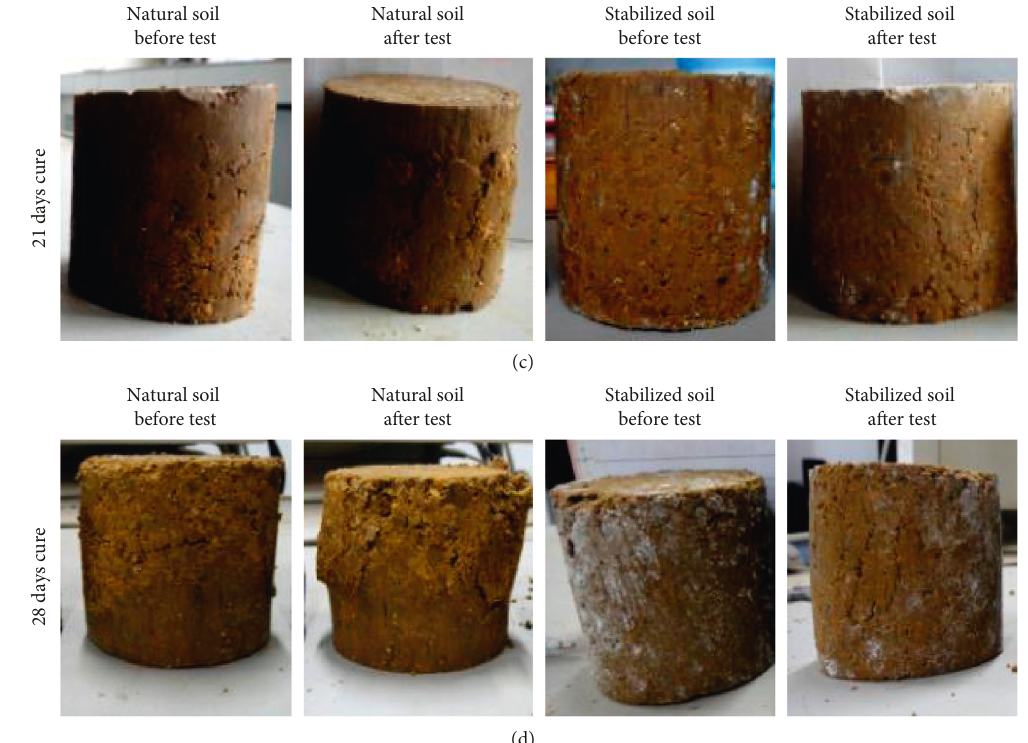
Figure 4: Photos of the samples before and after the unconfined compression tests.